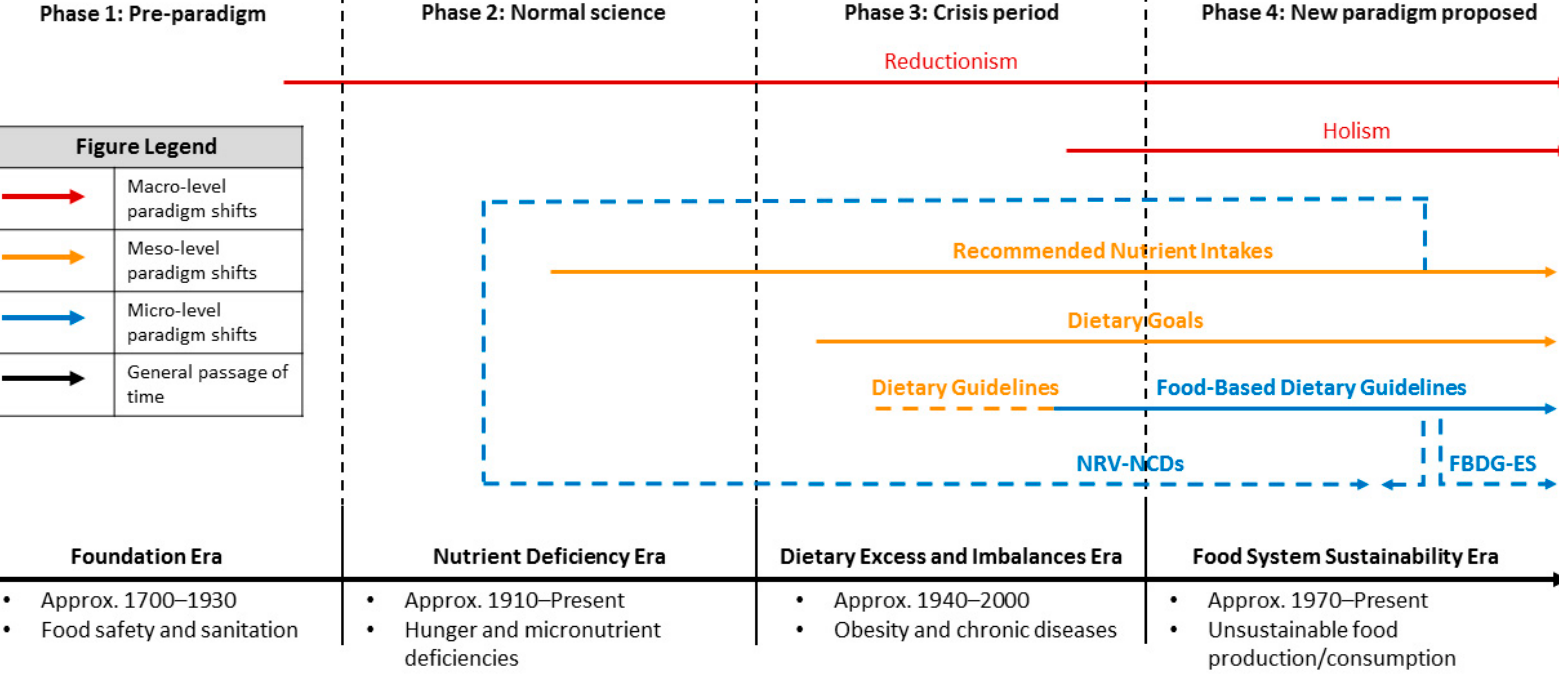
Figure 1. Layering of public health nutrition paradigms. NRV-NCDs = nutrient reference values – noncommunicable diseases; FBDG-ES = food based dietary guidelines – environmental sustainability.